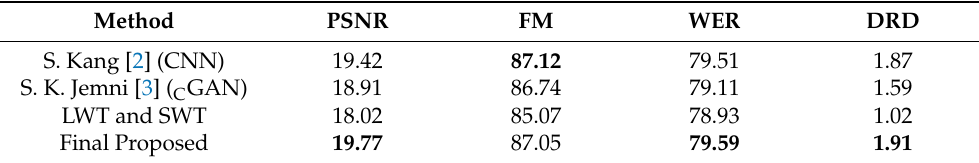
Table 6. Comparative results on S-MS [27]